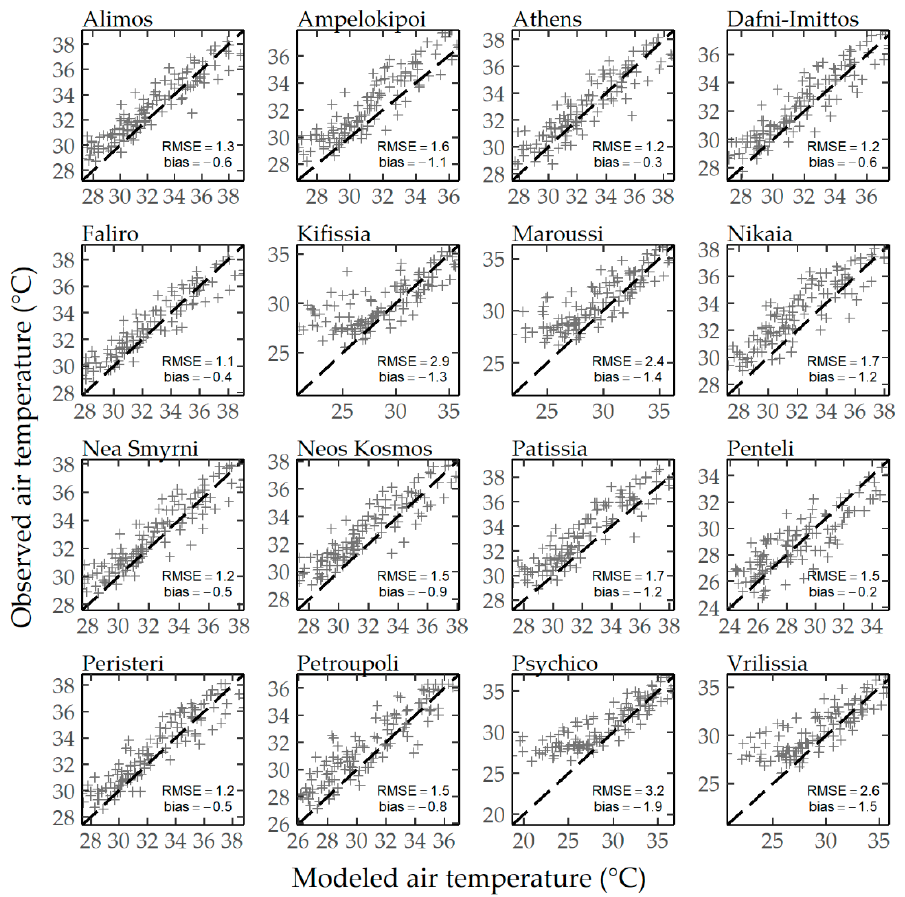
Figure 14. Comparison of the observed near-surface air temperature and the modeled near-surface air temperature from WRF (diagnostic variable T as ) (7–11 August 2017).